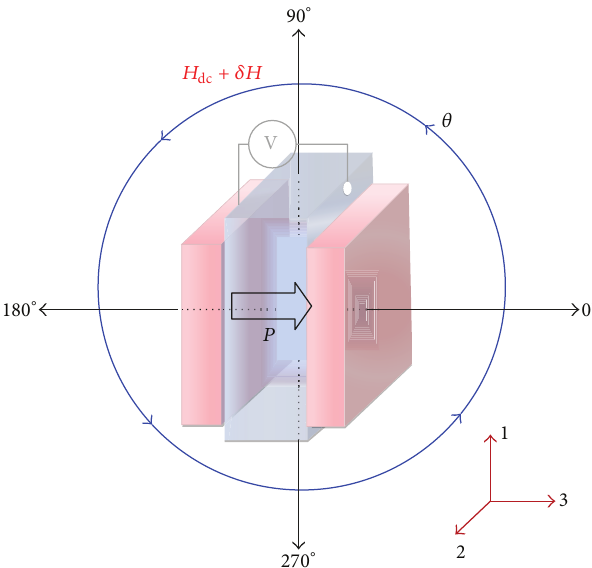
Figure 1: Schematic illustration of the FeBSiC/PZT/FeBSiC trilayer. The 𝜃 denotestheanglebetweenthedirectionsofmagnetic-fieldand the electric